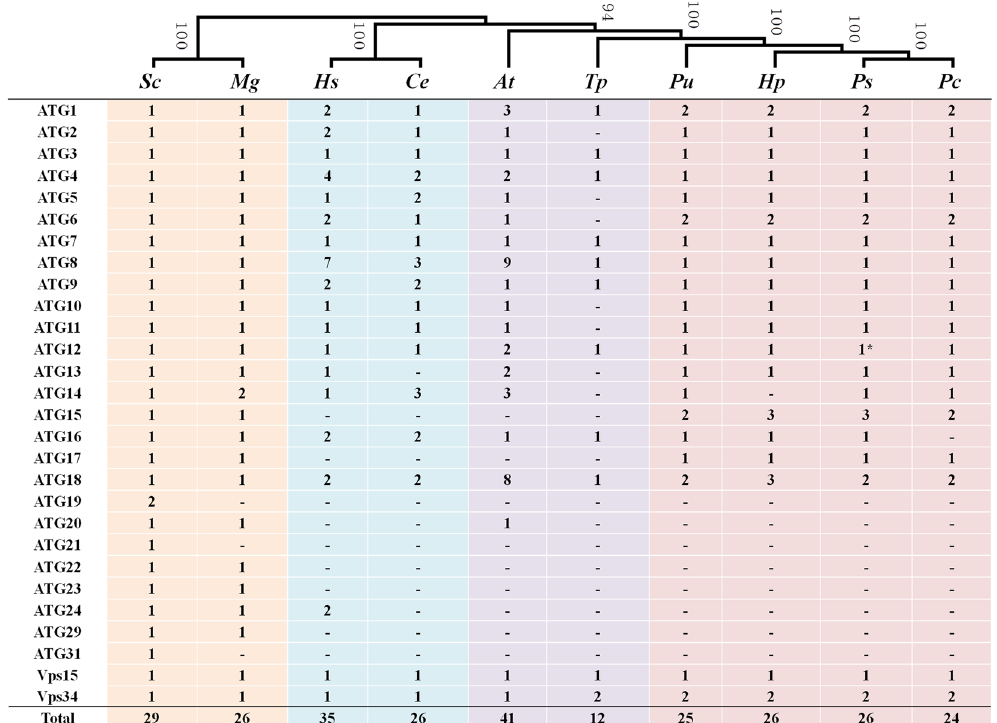
Figure 1. Distribution of autophagy-related (ATG) proteins in representative species. ATG proteins identified from P . sojae ( Ps ), P . capsici ( Pc ), H . parasitica ( Hp ), Py . ultimum ( Pu ), T . pseudonana ( Tp ), A . thaliana ( At ), C . elegans ( Ce ), H . sapiens ( Hs ), S . cerevisiae ( Sc ), and M. grisea ( Mg ) were compared. The distribution of putative ATGs appeared to be mostly restricted to oomycete species. Evolutionarily, the autophagy pathway of oomycetes appears more closely related to that of plants and animals than to that of